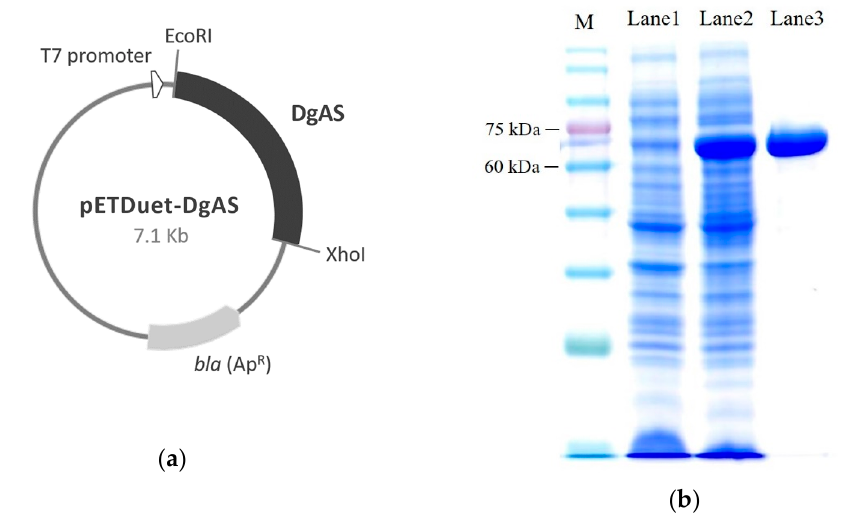
Figure 1. Production of the DgAS from Deinococcus geothermalis in E. coli . ( a ) Diagram of the constructed plasmid; ( b ) SDS-PAGE of the produced DgAS in recombinant E. coli . M: protein marker; lane 1: total protein without IPTG-induction; lane 2: total protein with IPTG-induction for 20 h; lane 3: purified DgAS.